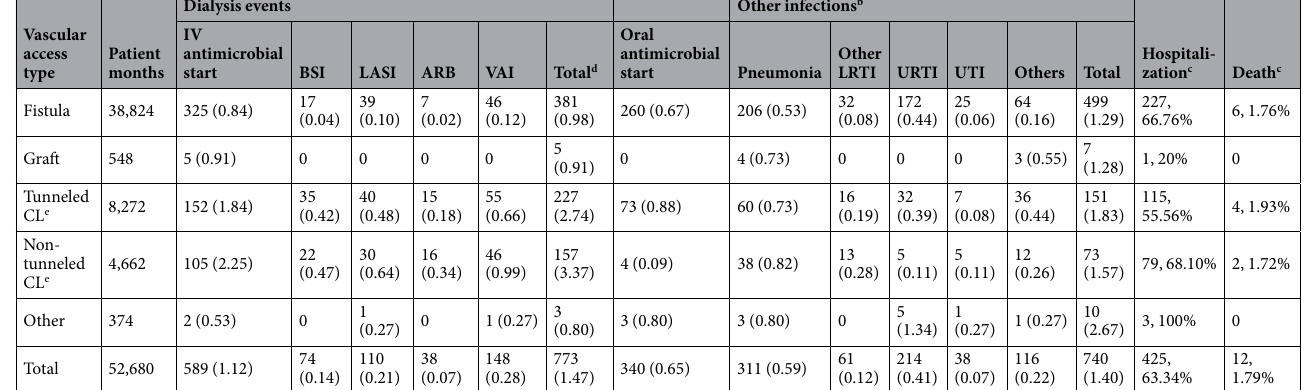
Table 2. The incidences of dialysis events, other problems and outcomes in HD patients a . a The figures in brackets are incidences (per 100 patient-months). b URTI, upper respiratory tract infection; LRTI, lower respiratory tract infection; UTI, urinary tract infection. c Hospitalization and death were calculated for those with dialysis events. d Total, the total number of IV antimicrobial start, BSI and LASI. e CL, central line.